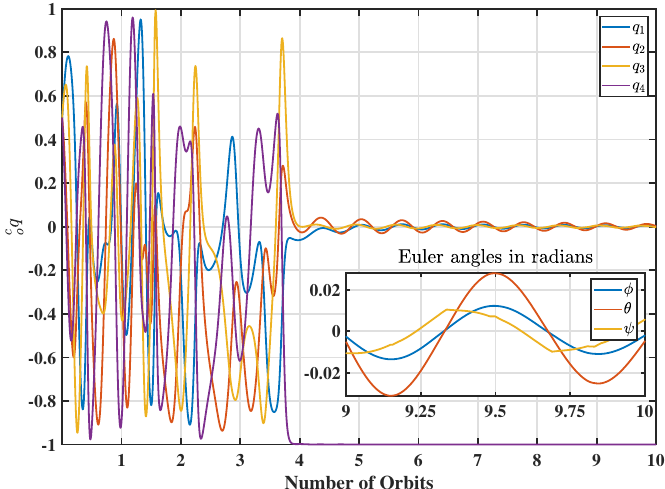
Figure 3. Quaternions achieve stability (up to an error represented in terms of Euler angles) with the